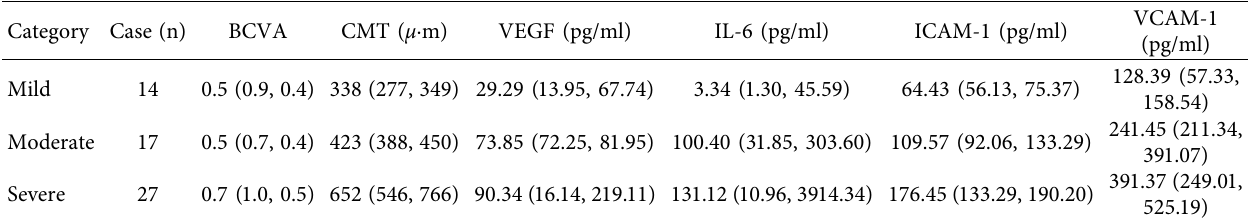
Table 2: BCVA, CTM, and the expression levels of VEGF, IL-6, ICAM-1, and VCAM-1 in the aqueous humor.